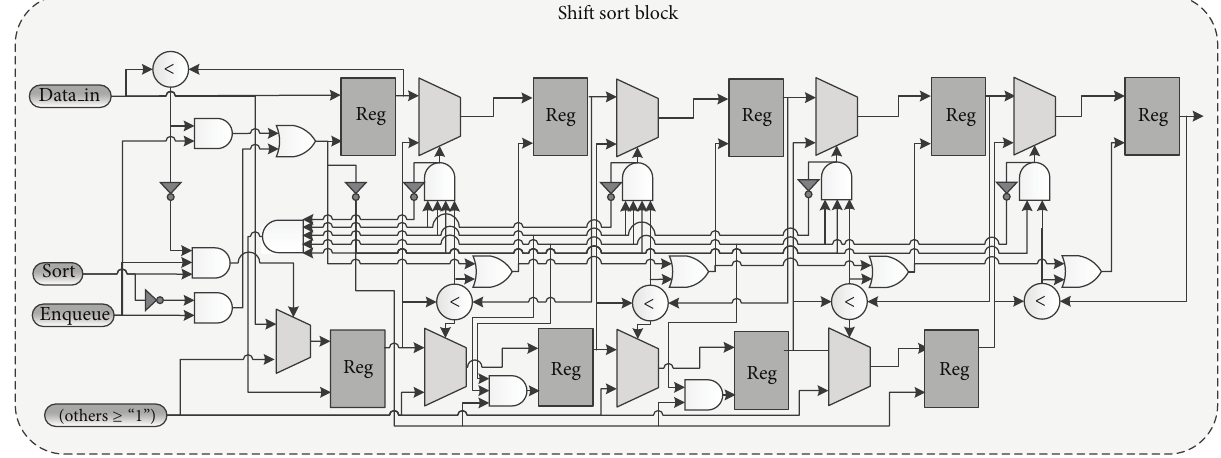
Figure 6: Shift sort hardware block diagram.